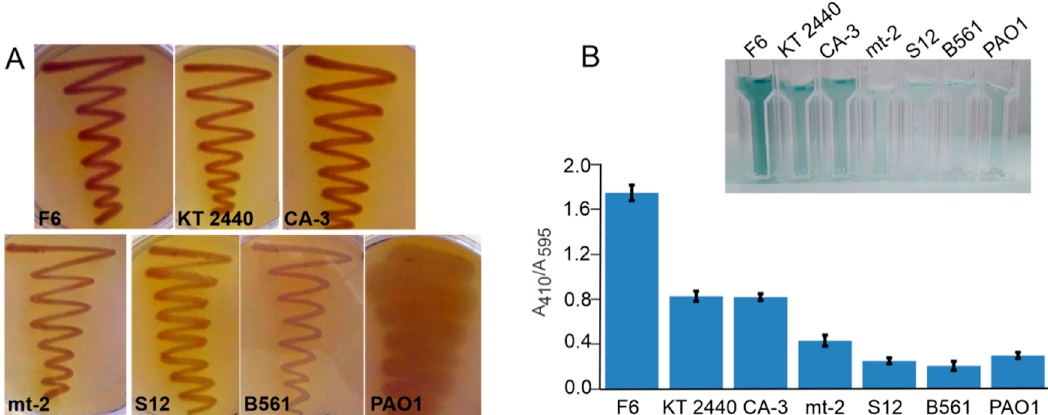
Figure 1. Laccase activity assay on guaiacol-containing plates ( A ) and in ABTS assay ( B ). Abbreviations F6, KT2440, CA-3, mt-2, S12, B561, and PAO1 refer to wild type strains P. putida F6,